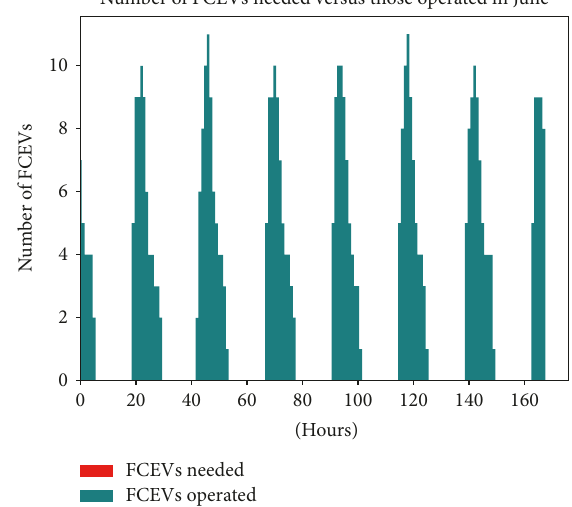
Figure 4: Number of FCEVs needed versus those operated every hour, in a week in December.